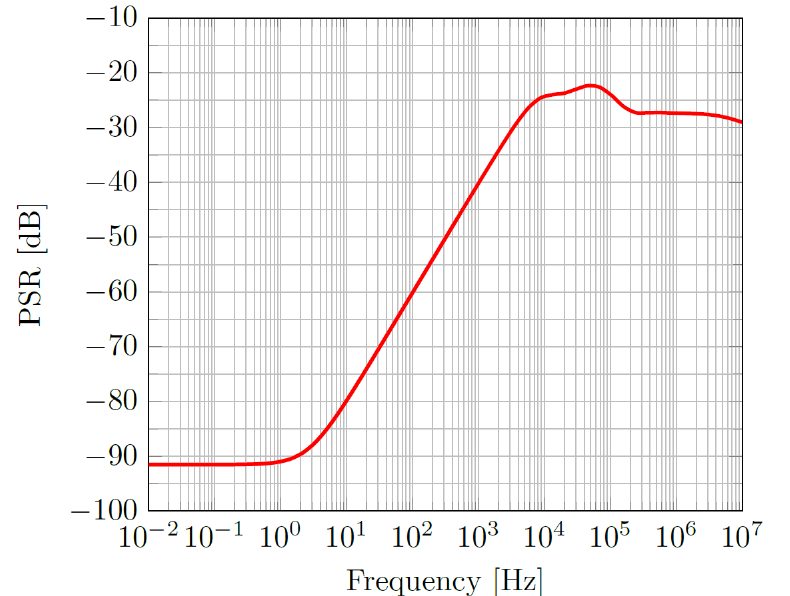
Figure 9. The PSR with C C at VDD post-layout